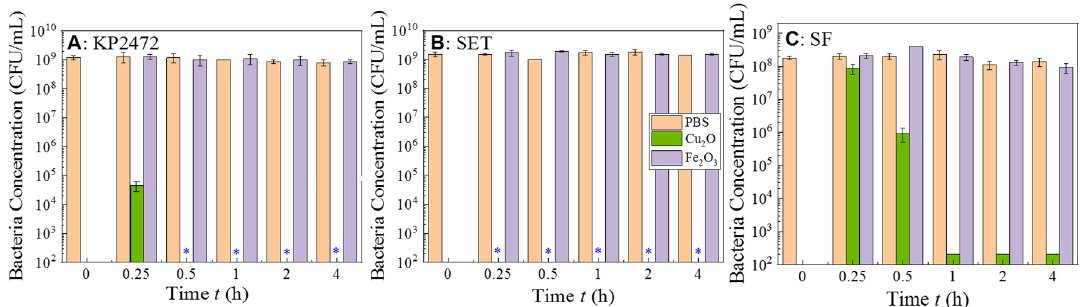
Figure 7. Antimicrobial tests of 1 mg / mL control Fe 2 O 3 and Cu 2 O NPs against various pathogenic bacteria ( A ) K. pneumoniae (KP2472), ( B ) S . Typhimurium (SET), and ( C ) S. flexneri (SF). These tests